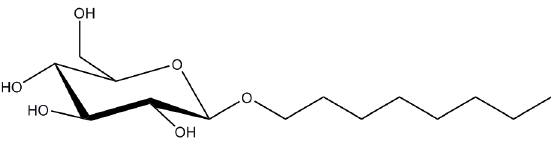
Figure 5. Structure of Octyl glycoside (OG) (chemical formula is C 14 H 28 O 6 ). OG has gained its